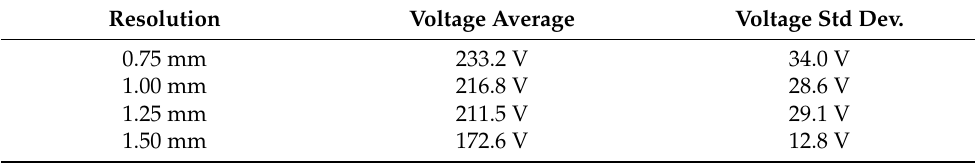
Figure 6. Initial evolution of arc voltages as a function of the minimum resolution in the mesh. x CO = 0.5, I = 1000 A, L a = 0.05 m. Table 3. Arc voltages from mesh-dependence tests during the period of 5 to 10 ms.